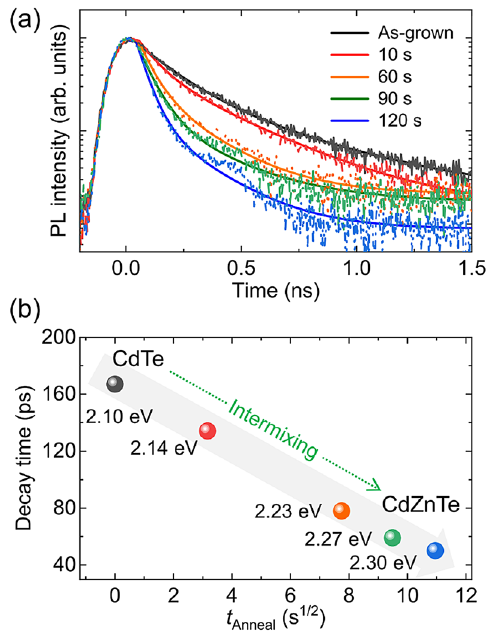
Figure 5: (a) Time-resolved PL spectra for the as-grown and post- annealed QDs measured using a TCSPC module at the PL peak of each sample. Solid lines indicate fitting curves with a biexponential function. (b) PL decay times of QD samples as a function of the annealing time. A linear relation between the decay time and the square root of annealing time is shown as a black line (slope (cid:1) √ α (cid:3) − 11 × 10 − 12 ). QD, quantum dot; PL, photoluminescence; s TCSPC, time-correlated single photon